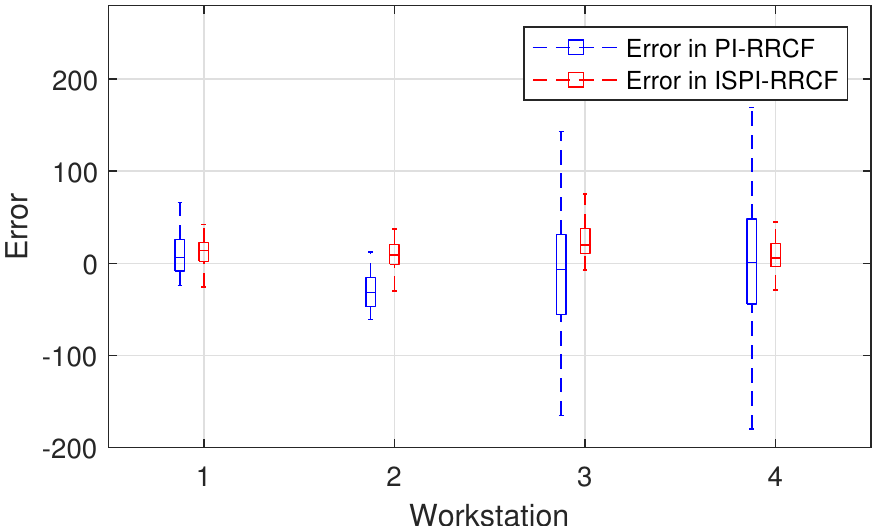
Figure 11. Error distributions between the planned and current WIP of the workstations.